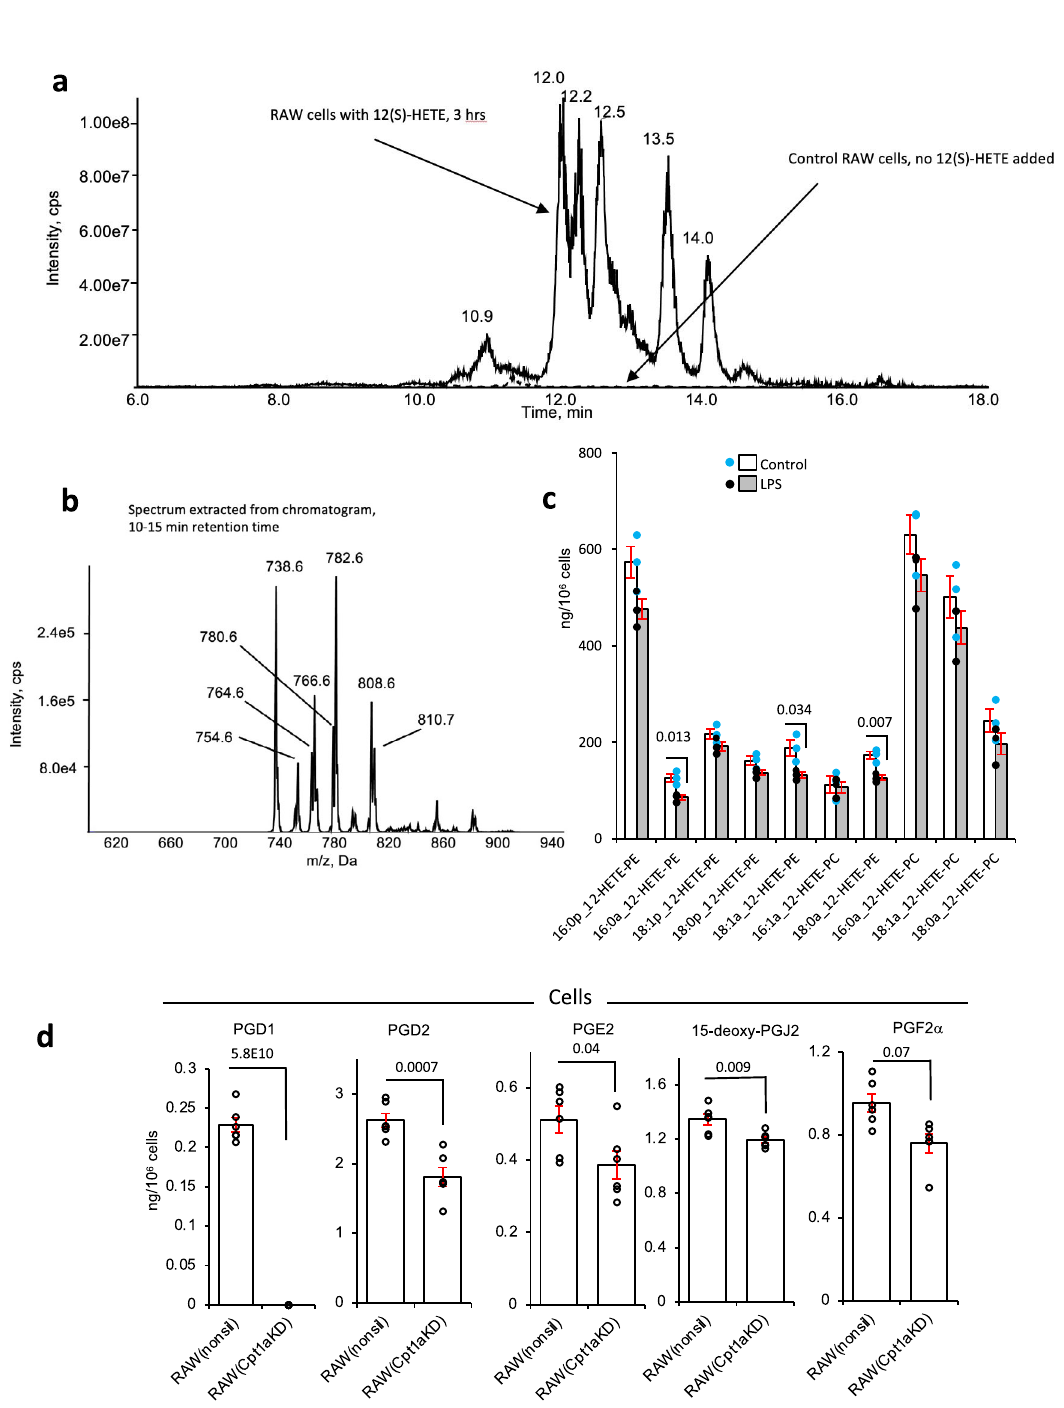
Fig. 3 Identi fi cation of phospholipid-esteri fi ed 12-HETE in RAW cells, and CPT1 knockdown reduces PG levels in RAW cells. a – c Cells (10 6 ) were incubated for 3 h with 12(S)-HETE ± LPS before lipids were extracted and analyzed as in Methods. Precursor LC/MS/MS was undertaken as described in Methods, scanning for ions that fragment to generate HETE. a Chromatogram showing elution of precursors that generate product ions with m/z 319.2. b MS spectrum from 10 – 15 min showing PE and PC species that contain 12-HETE. c Quanti fi cation of 12-HETE PE and PC species that are formed following incubation of RAW cells with 12(S)-HETE ( n = 3, mean ± SEM, separate wells of cells) compared with/without LPS, Student ’ s t -test, two-tailed. Where no bar is shown no signi fi cant difference was seen. d Cpt1a knockdown dampens cellular levels of PGs in RAW cells. RAW cells expressing either the non- silencing (RAW nonsil ) or Cpt1a knockdown siRNA (RAW Cpt1a KD ) were treated with LPS (100 ng/ml) for 24 h and cell levels of PGs measured using LC/ MS/MS as in Methods ( n = 6, mean ± SEM, separate wells of cells). Student ’ s t -test, two-tailed. Where no bar is shown no signi fi cant difference was seen.